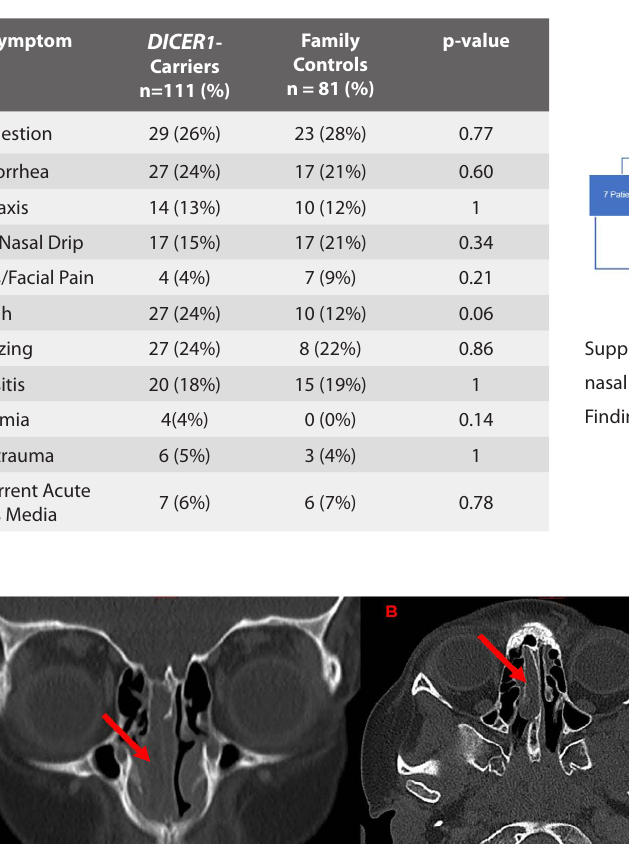
Supplementary Table 1. Frequency of sinonasal signs and symptoms in DICER 1 -carriers vs. family controls